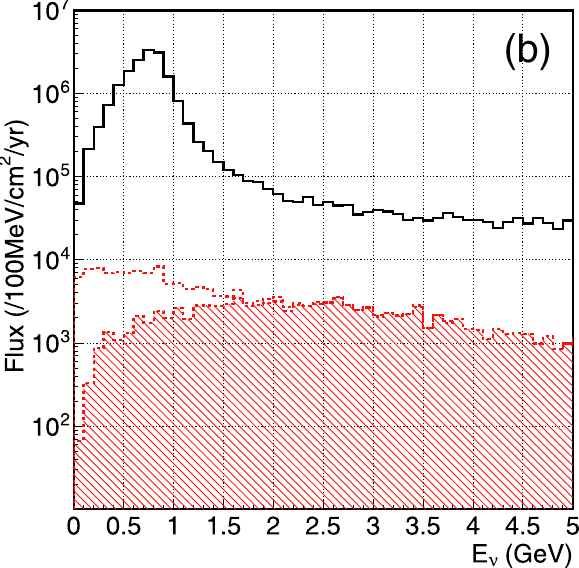
Fig. 43 Comparison of ν e and ν μ spectra for the 2 ◦ off-axis beam. The solid (black) histogram is ν μ and the dashed (red) one is ν e . The hatched area is a contribution from the kaon decay. The low energy ν e component is due to μ from π